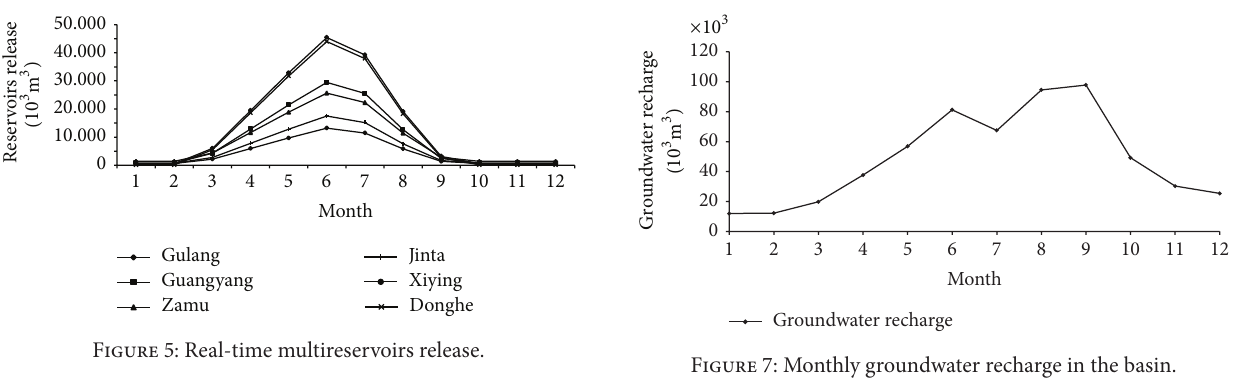
Figure 7: Monthly groundwater recharge in the basin.